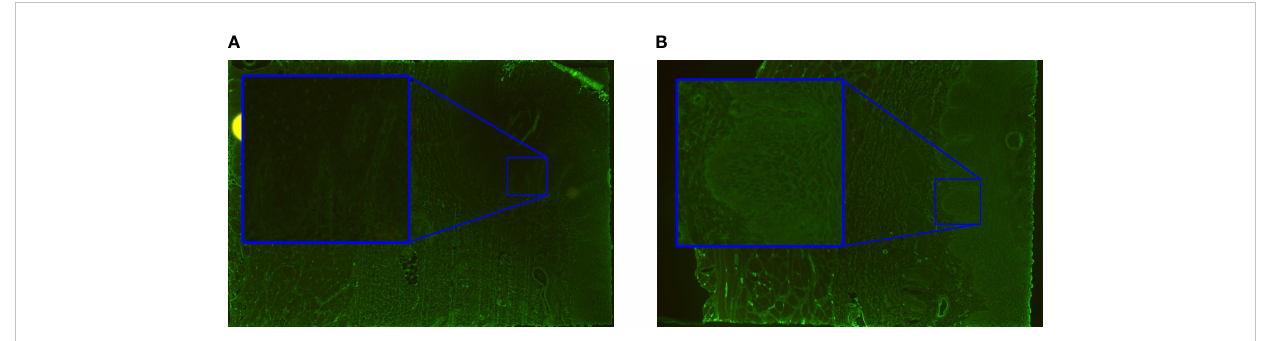
FIGURE 6 Classi fi cation errors on esophagus with faint staining. (A) ‘ BMZ ’ pattern incorrectly classi fi ed as ‘ negative ’ . (B) ‘ Intercellular ’ pattern incorrectly classi fi ed by the algorithm as ‘ BMZ ’ in a patient with pemphigoid disease.